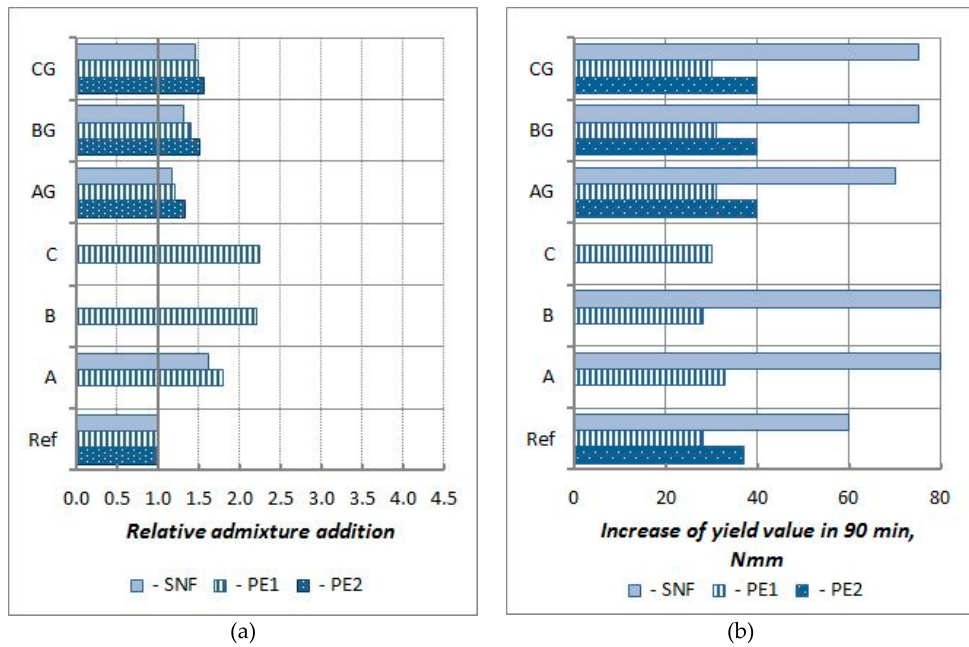
Figure 15. Influence of CFA on effectivness of SNF, PE1 and PE2 (mortars of w/b = 0.45); ( a ) relative admixture content (in relation to reference mortar without CFA) neccessary to be added to obtain mortar with g5 = 20 Nmm; ( b ) increase in yield value g of mortars with initial yield value g equal 20 Nmm in time.